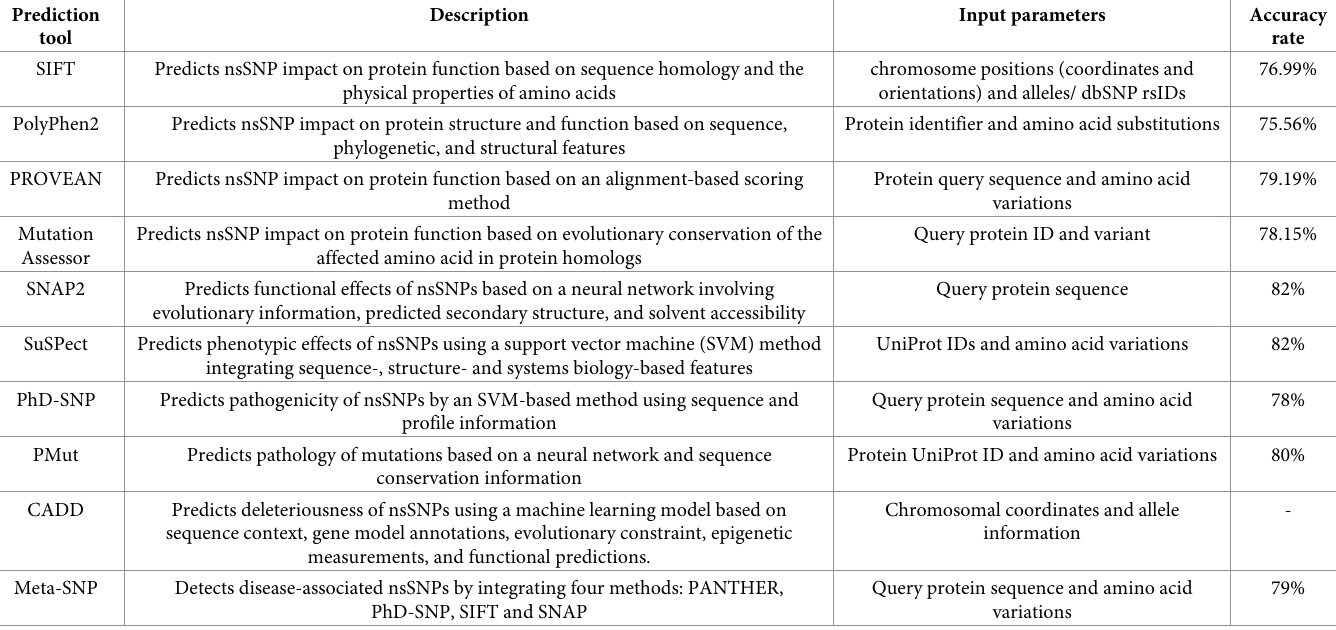
Table 1. List of web-based bioinformatics tools used in the study for the identification of most deleterious nsSNPs along with their description, input parameters, and accuracy rate. Prediction